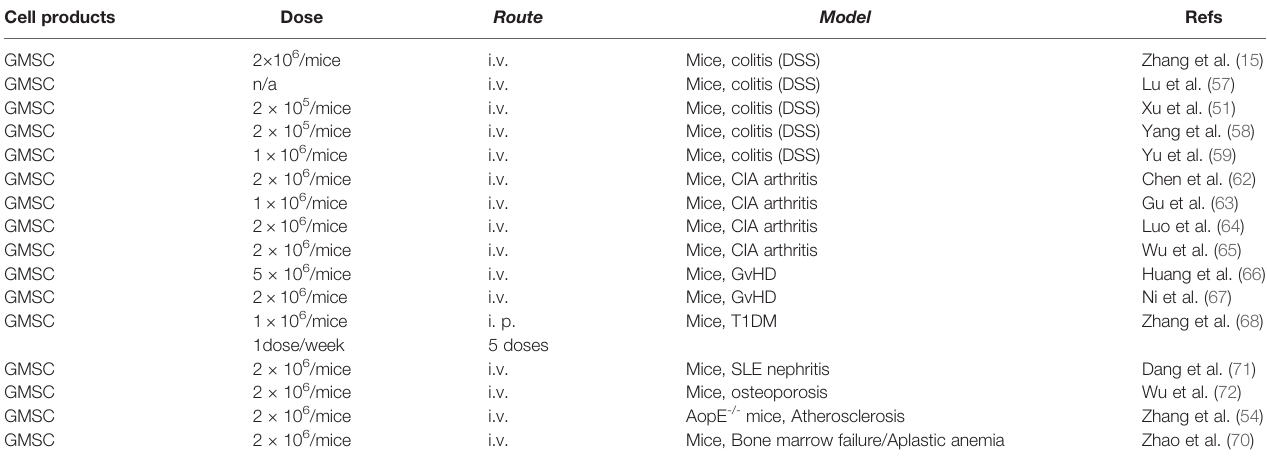
TABLE 4 | GMSC-based regenerative therapy in autoimmune and in fl ammatory disorders. Cell